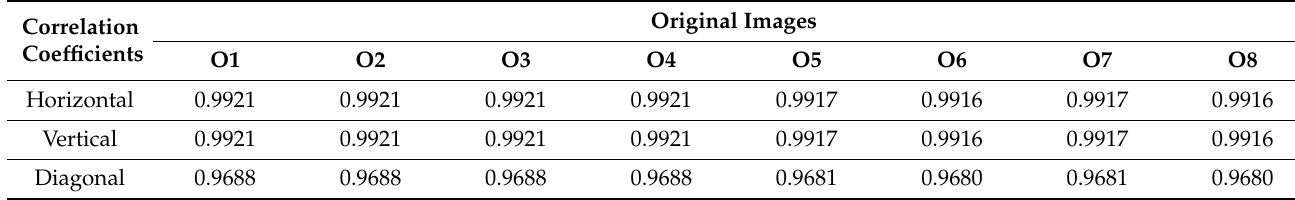
Table 1. Correlation coefficients of adjacent pixels of original images.